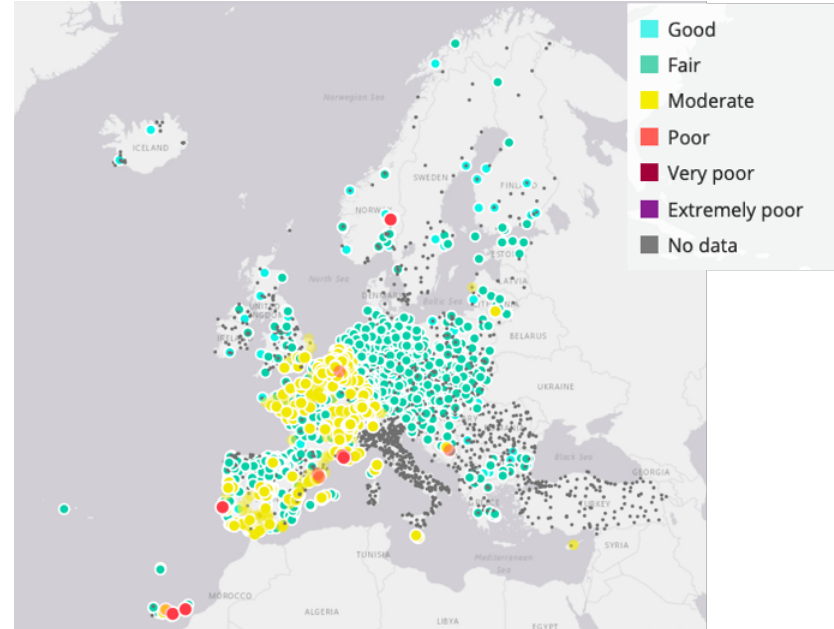
Figure 8. Air quality map from the European Environment Agency website